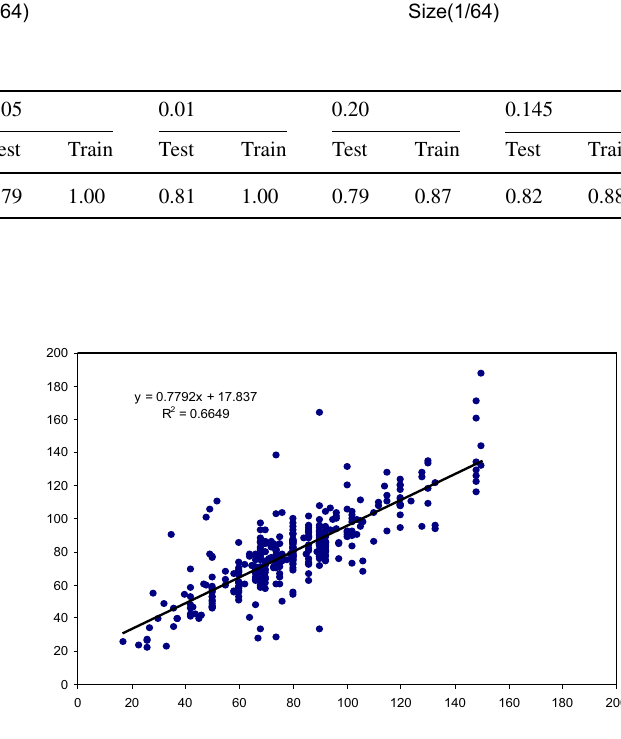
Fig. 9 Actual versus predicted choke size for FL model testing (Radii =